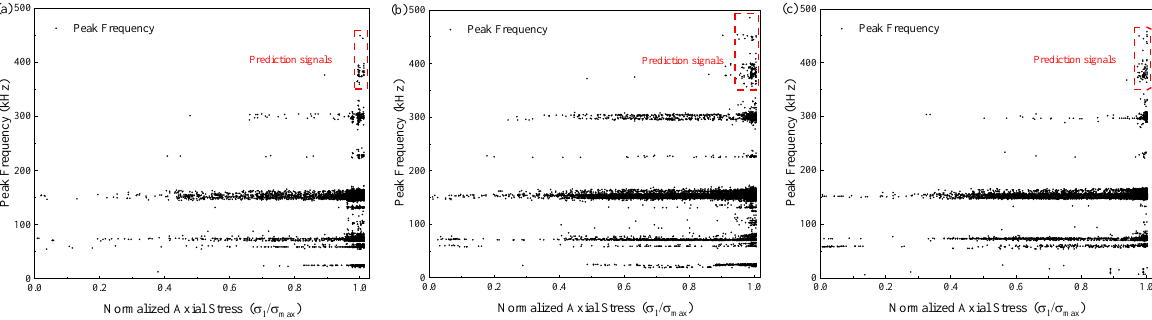
Figure 6. Relationship between amplitude distribution and normalized axial stress. ( a ) A1, ( b ) B1, ( c ) C1.